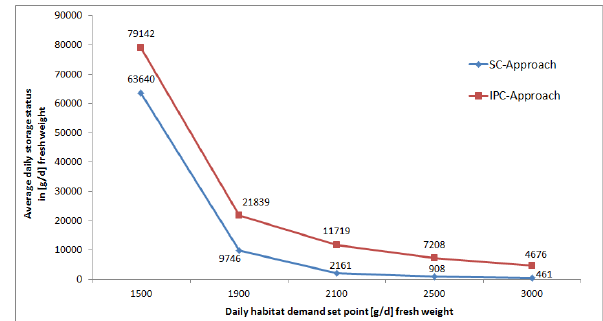
Figure 14: Average daily storage situation for IPC (red line) and SC (blue line). At a demand set point of 1500 g/d, the theoretical average storage system status results in 79 kg/d (IPC) and 63 kg/d (SC) so that food spoilage is unavoidable. With increasing crew demand set points, the storage system status, meaning the average stored biomass, decreases. At 2100 g/d, the average storage status is 2.2 kg/d (SC) in comparison to 11.7 kg/d (IPC), which is 5.4 times less.